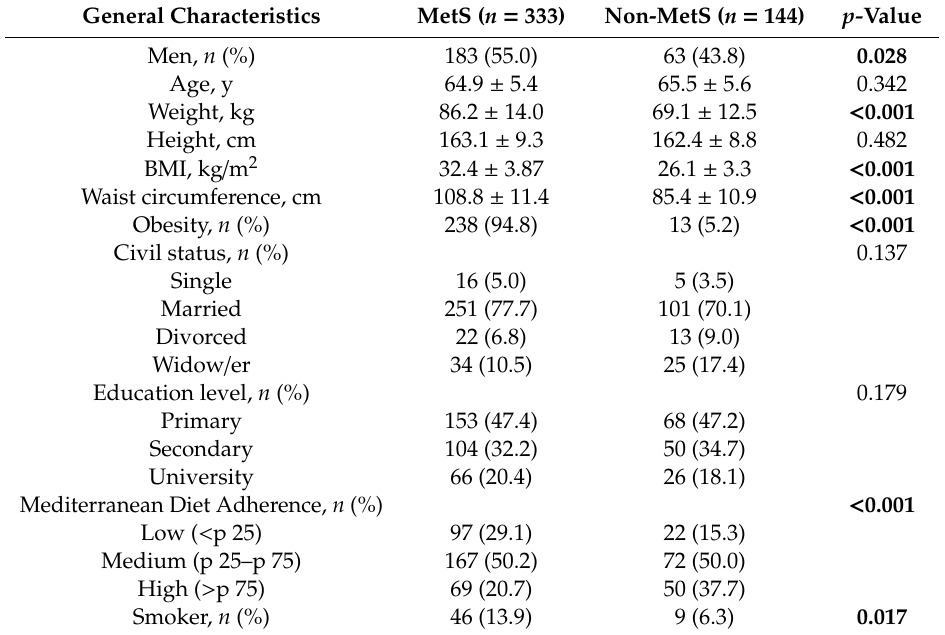
Table 1. Baseline characteristics of study sample between MetS and non-MetS